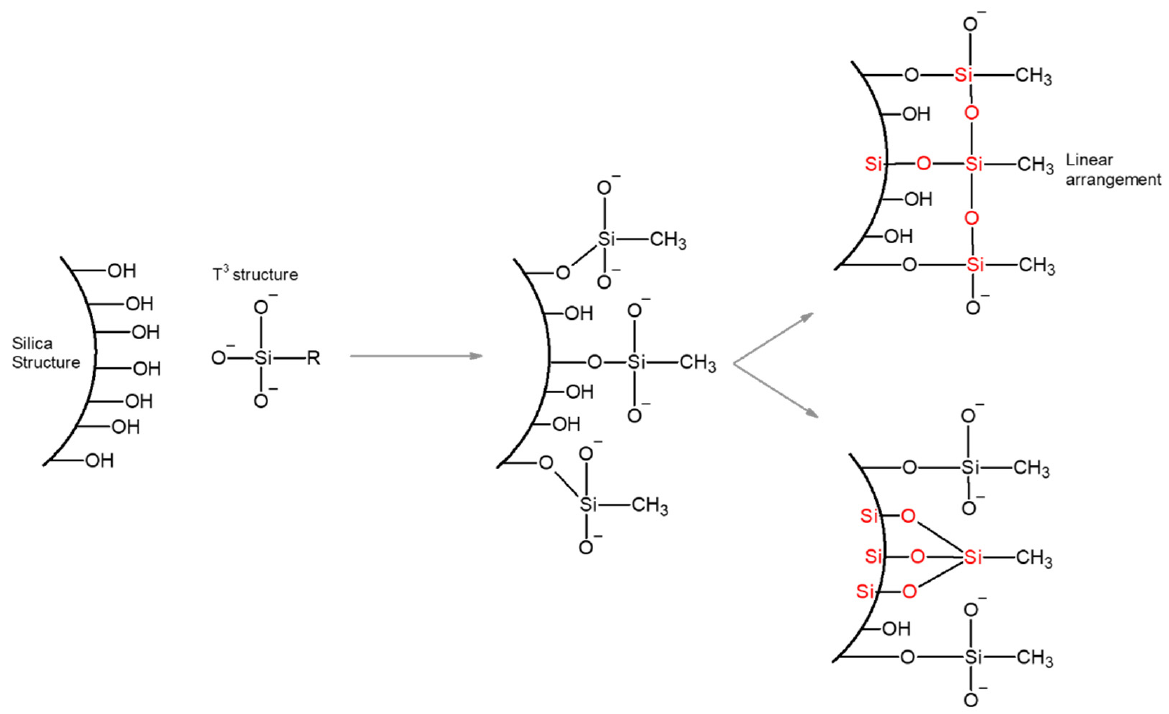
Figure 4. Schematic representation of the linear arrangement of the T 3 structure [46].